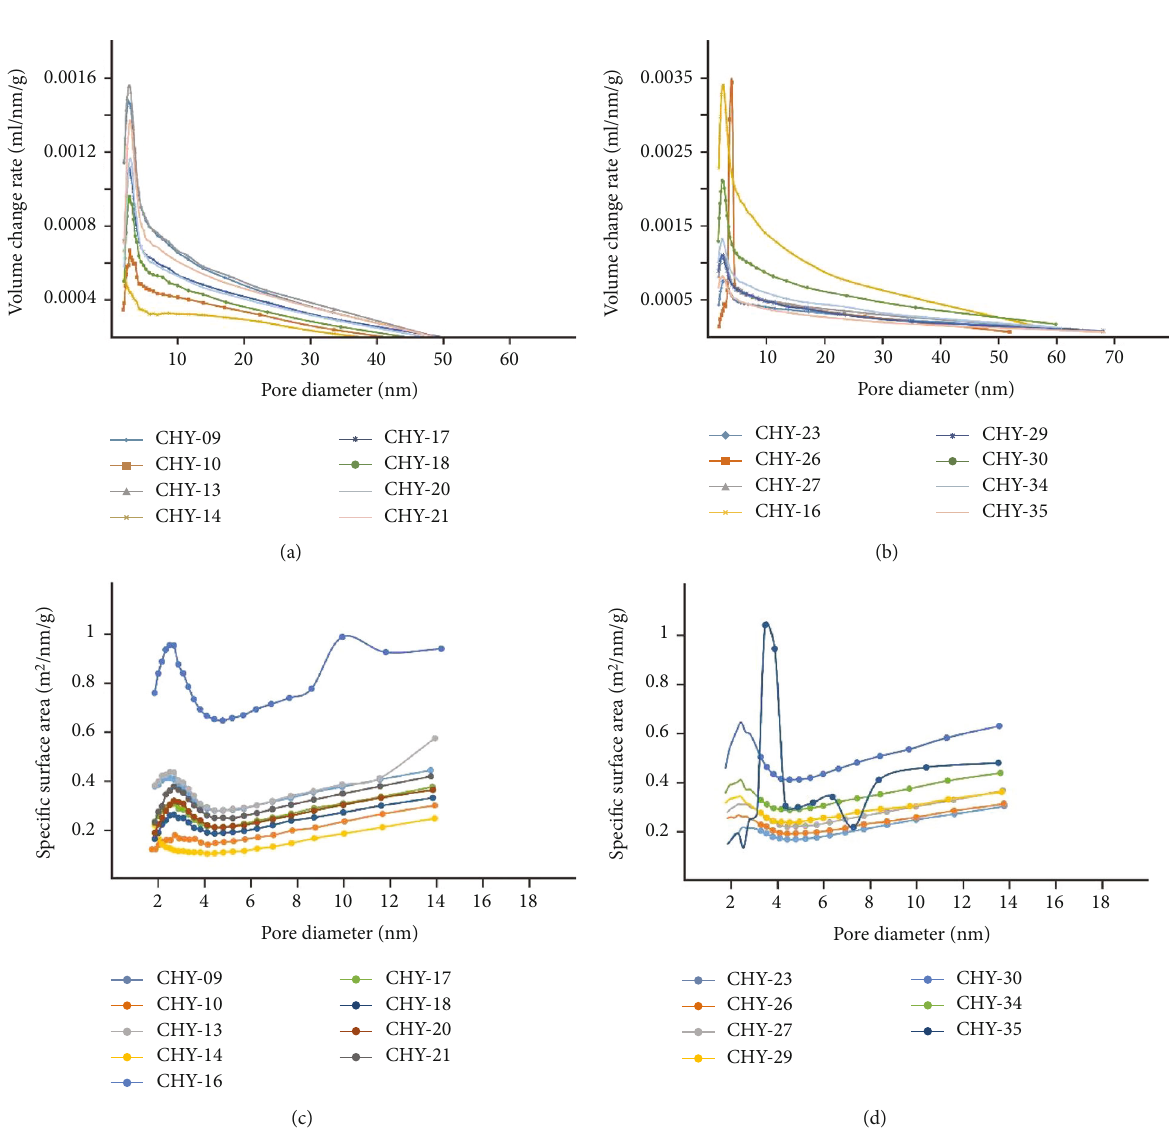
Figure 8: Nitrogen adsorption curve with the pore